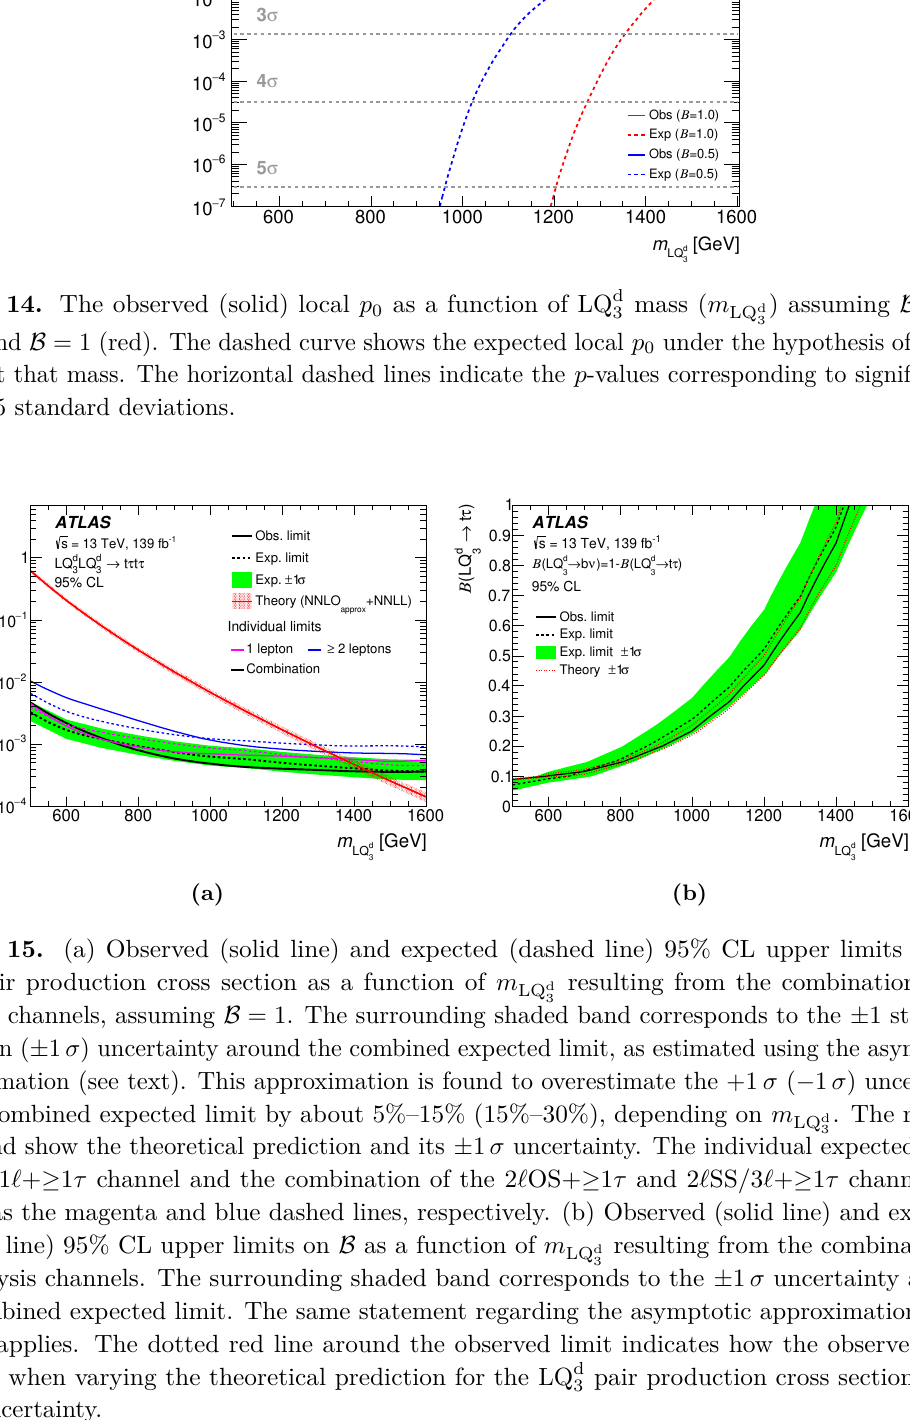
mass ( m ) assuming B = 0 . 5 LQ d 3 3 under the hypothesis of a LQ d 0 3